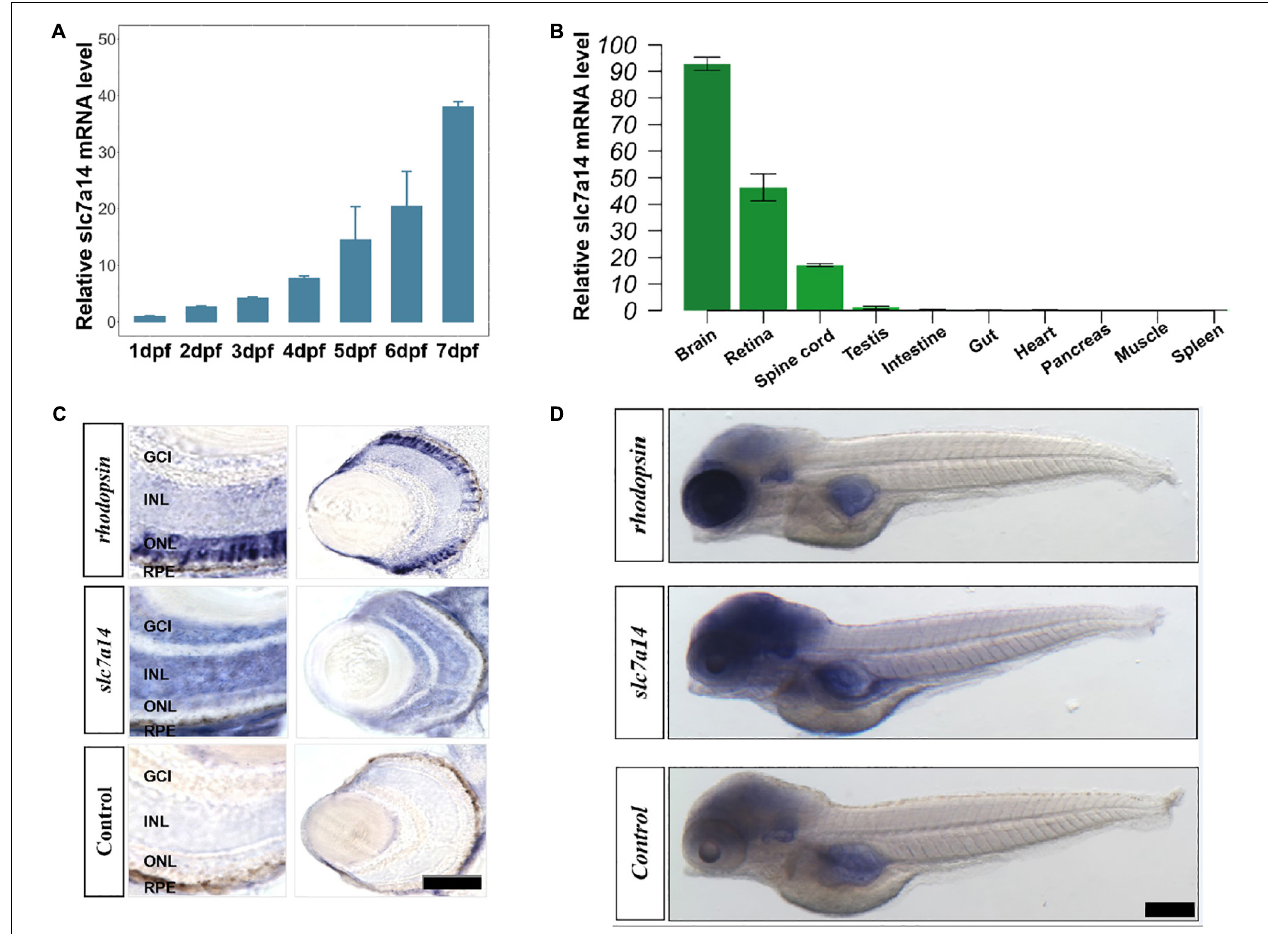
FIGURE 1 | Spatiotemporal expression pattern of slc7a14 in zebrafish. (A) The slc7a14 expression increased remarkably from 1 to 7 dpf. (B) Spatial expression pattern of slc7a14 in 3-month-old adult male zebrafish. (C) In situ hybridization (ISH) of slc7a14 in retinas and eyes. ONL, outer nuclear layer; INL, inner nuclear layer; GCL, ganglion cell layer; RPE, retinal pigment epithelium. Scale bar = 50 µ m. (D) ISH of slc7a14 in embryos. Scale bar = 100 µ